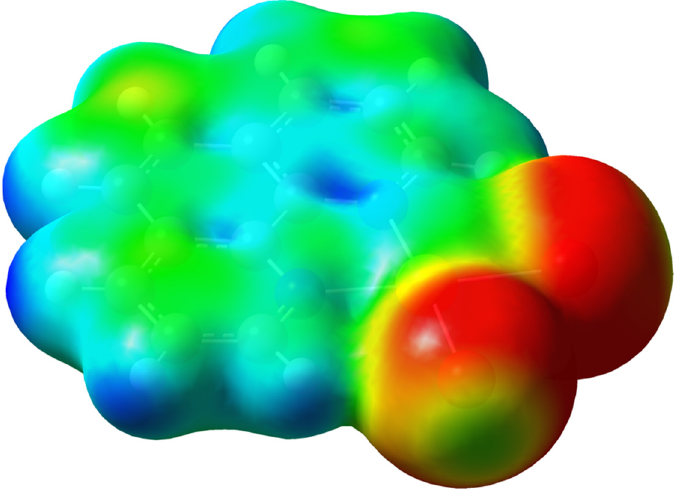
Figure 3. Potential electrostatic energy map [range 0.09 (red)–0.20 (blue) a.u.] calculated for the [Au(phen)Br 2 ] + cation at the DFT level on the density map (electron density = 9.0·10 − 3 |e|/Bohr 3 ).